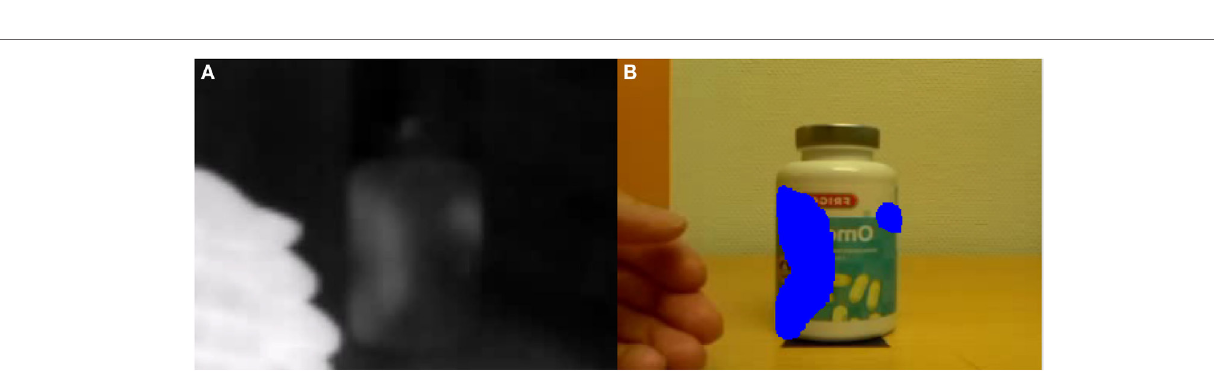
FigUre 5 | A simple example of inference from a video, extracting heat traces and not humans, via thresholds, morphology, and a basic shape model for touching: (a) thermal image and (B) RGB image with heat traces drawn by the